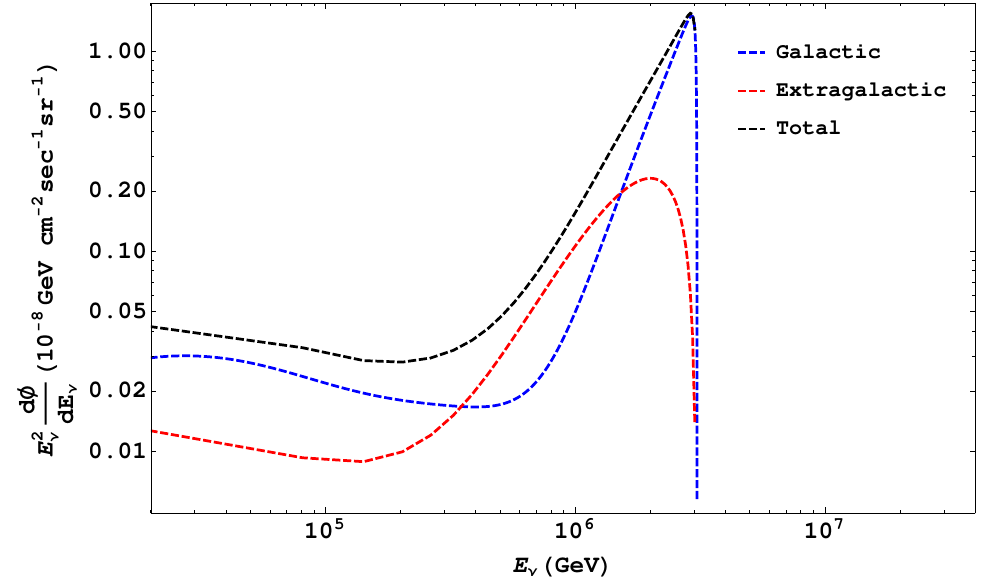
Figure 4 . The dashed blue and red lines show the predicted di(cid:11)erential neutrino (cid:13)ux at Earth from RH sneutrino decay accounting for galactic and extragalactic contributions, respectively. The dashed black line indicates the total di(cid:11)erential neutrino (cid:13)ux which is a sum of these two. We have used m ~ = 6 : 5 PeV, m N = 8 PeV, m = 1 : 5 PeV as our benchmark point, which results in 3 = 2 N 1 (cid:28) ~ (cid:24) 10 24 N 1